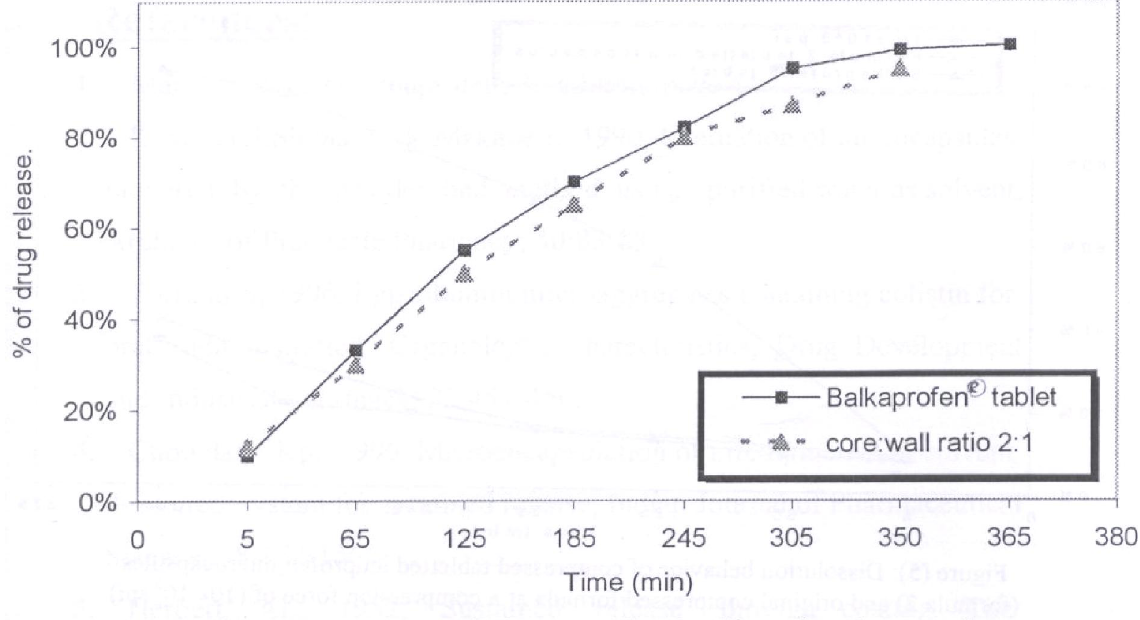
Figure (3): Release property of 2:1 core:wall ratio of ibuprofen microcapsules prepared by a modified organic method and Blakaprofen ® tablet using pH 6.8 phosphate buffer at 37ºC.